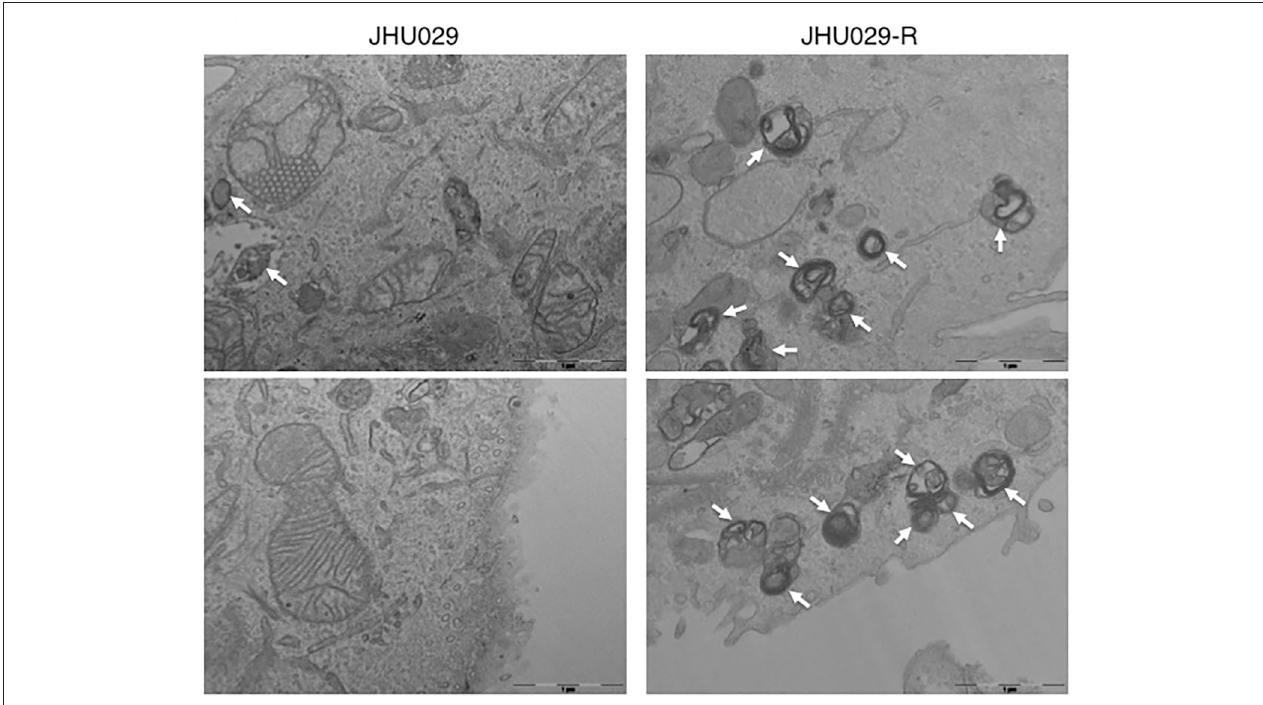
FIGURE 4 | Autophagy vesicles in cancer cells sensitive and resistant to chemotherapy. TEM images showing the presence of autophagy vesicles in JHU029 cell lines derived from laryngeal cancer, sensitive, and resistant (R) to cisplatin (see arrows). As was demonstrated by our group (187), cancer cells resistant to chemotherapy generate more autophagy vesicles than sensitive ones, which is correlated with the resistant phenotype developed.